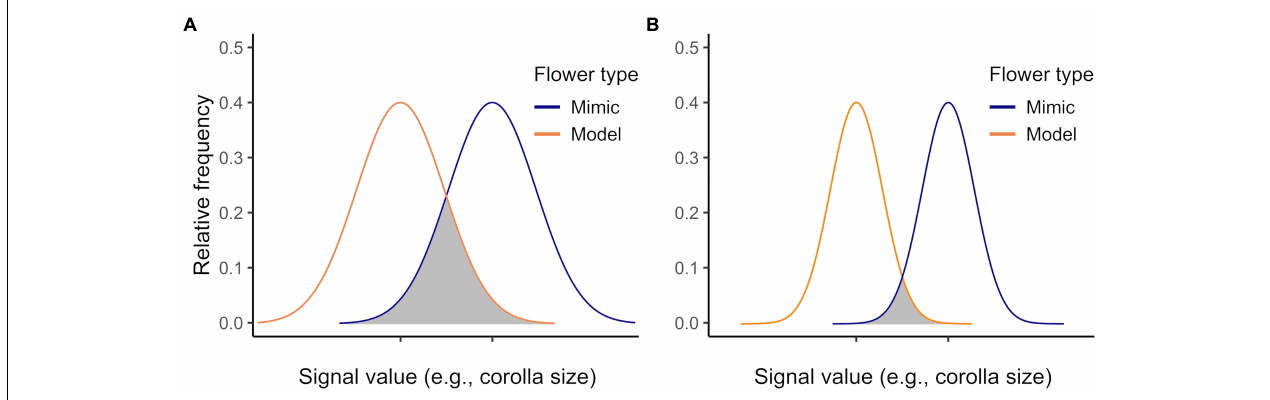
FIGURE 1 | How signal parameters of models and mimics influence receiver behavioral responses. Signal parameters are modeled as Gaussian probability density functions. The more the signal distributions overlap, the greater the uncertainty of signal stimuli for the receiver (grey shading; compare greater overlap in “ A ” to “ B ”) (see also Lynn et al., 2005).